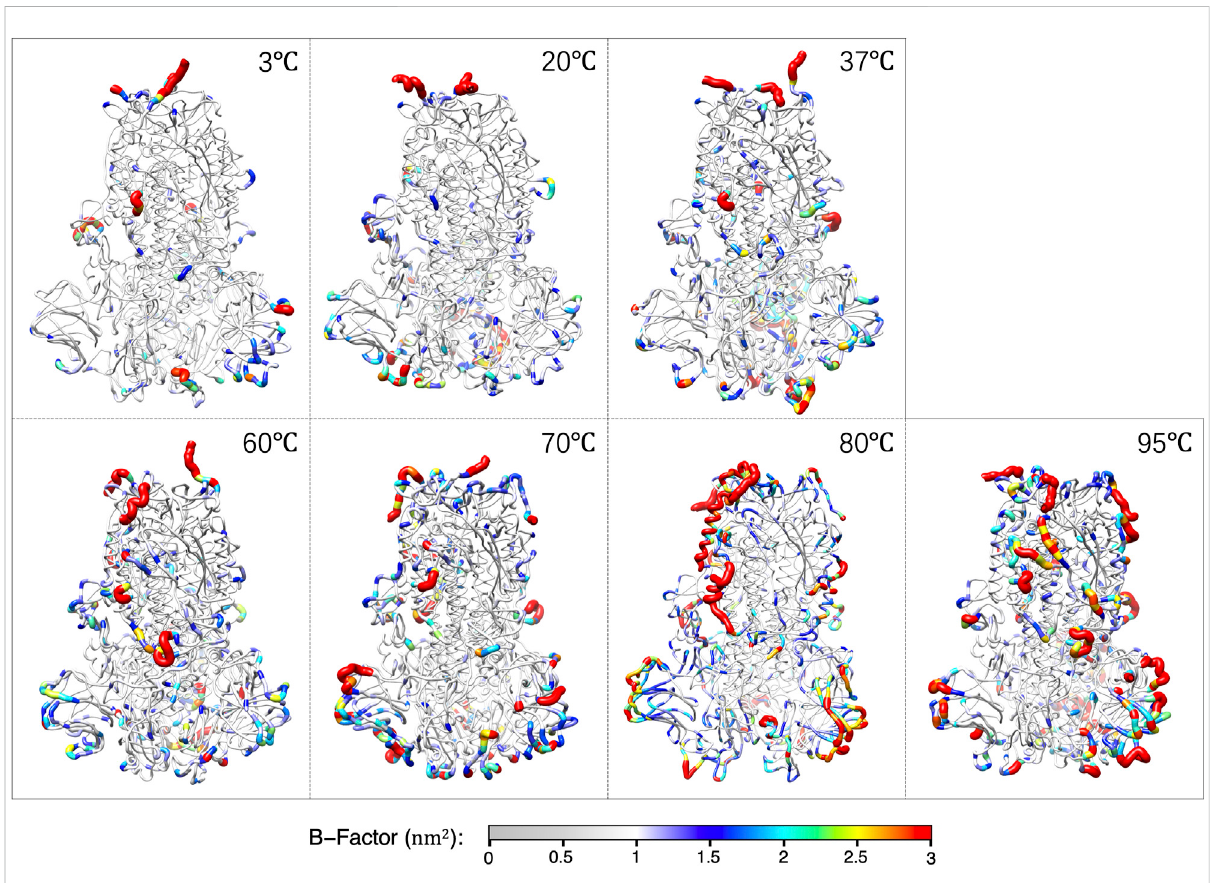
FIGURE 2 The averaged structures over the last 0.5 μ s of S-protein colored by the B-factors at each